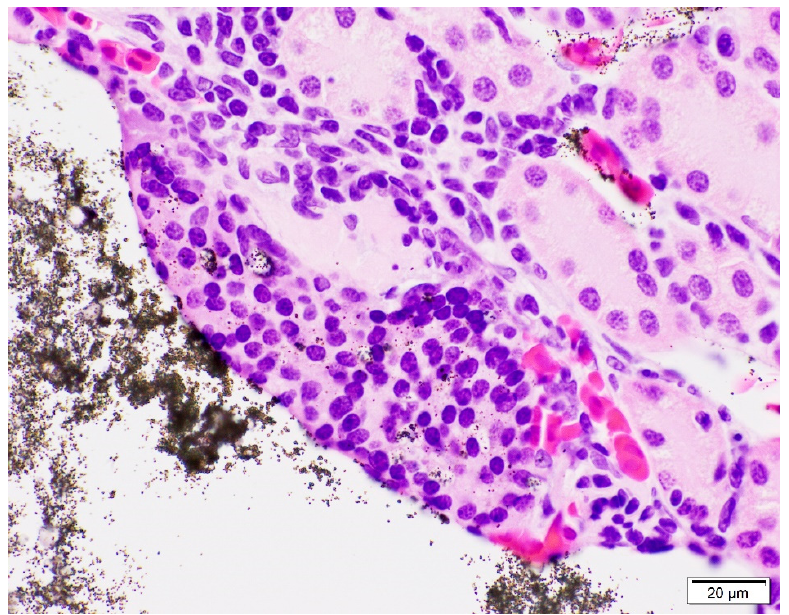
Figure 3. Microscopic examination of the kidney of a marine toad ( Rhinella marina ) 62 days after visible implant elastomer (VIE) tagging in the right distal limb. 100× magnification shows granu- lomatous nephritis associated with migrated VIE material in the small vasculature (vasa recta) of the kidney. Phagocytosis of VIE granules, visible within the surrounding macrophages, provides further evidence for the inflammatory reaction to the VIE material in the kidney.